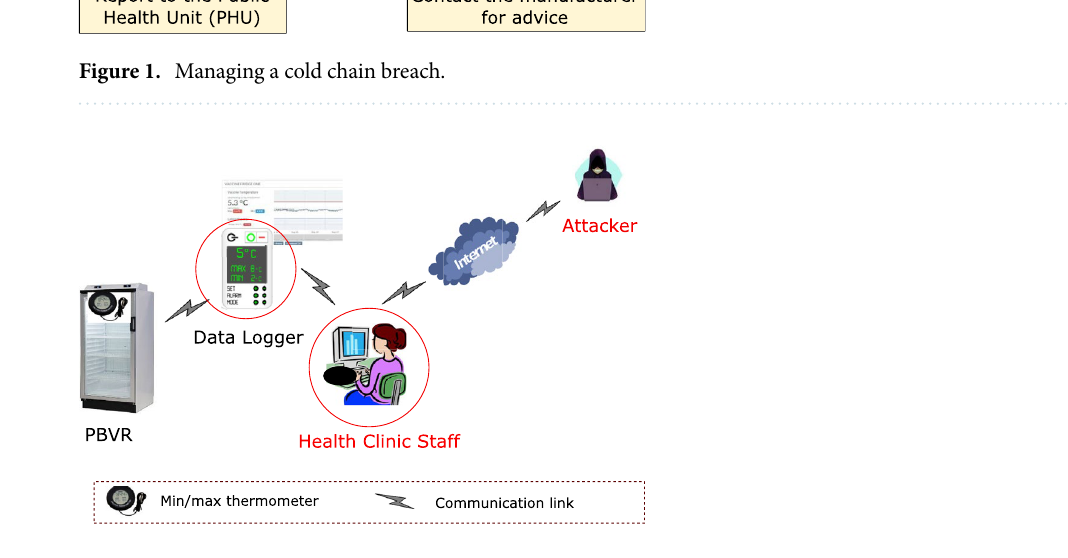
Figure 2. An external attack